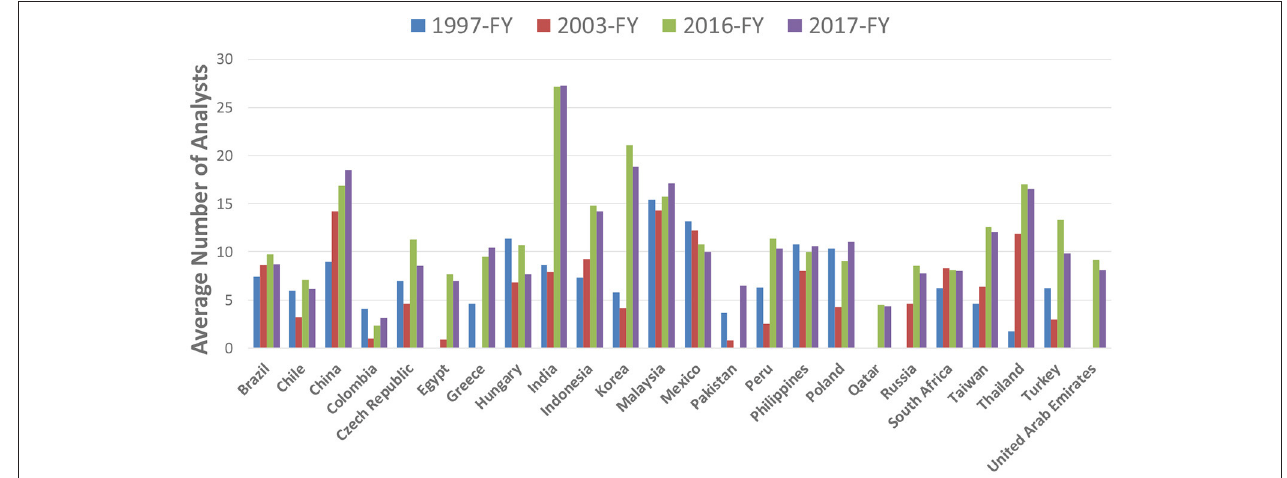
FIGURE 2 | Evolution of analyst coverage for EM securities (by